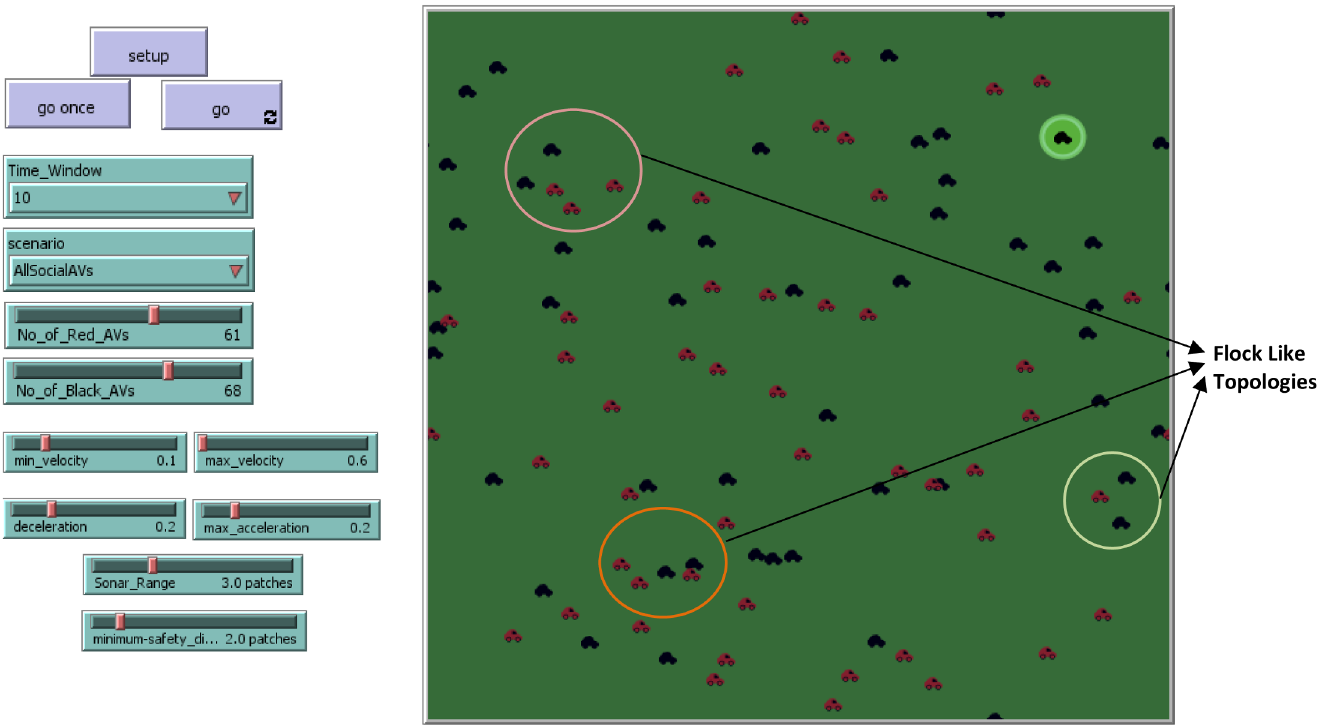
Fig 3. Main simulation screen of Richardson’s arms race model inspired agent-based collision detection and avoidance scheme.